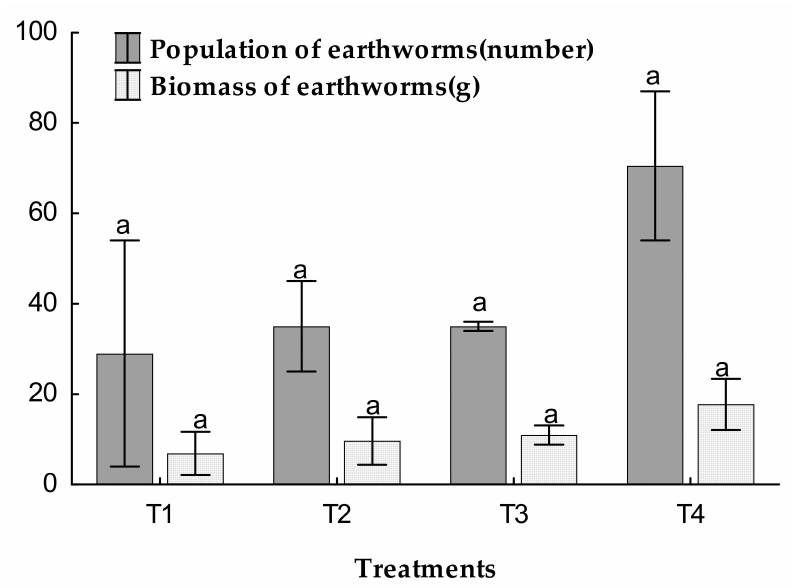
Figure 4. Population (number) and biomass of earthworms (g) after 60 days of vermicomposting. Bars indicate the standard error of the mean (n =